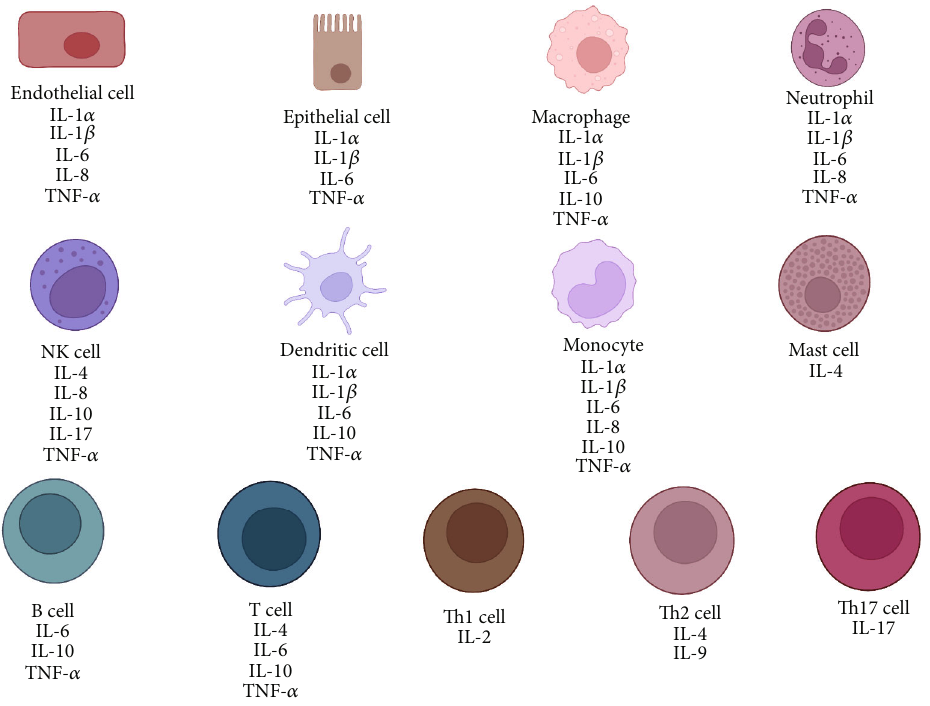
Figure 2: Schematic illustration of di ff erent cells expressing various